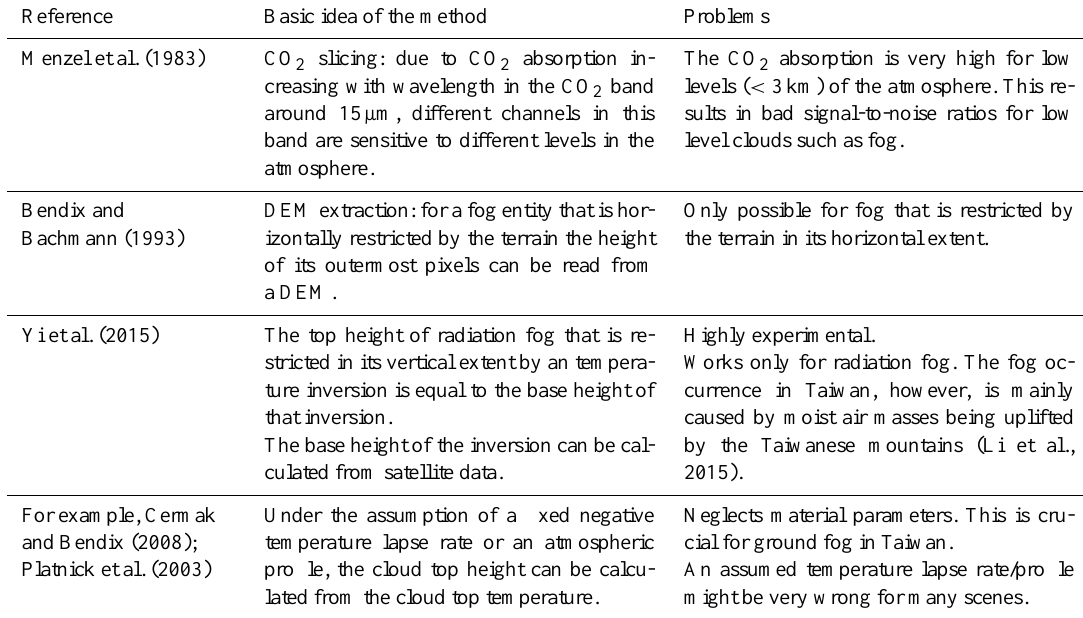
Table 1. Different cloud height retrieval methods.